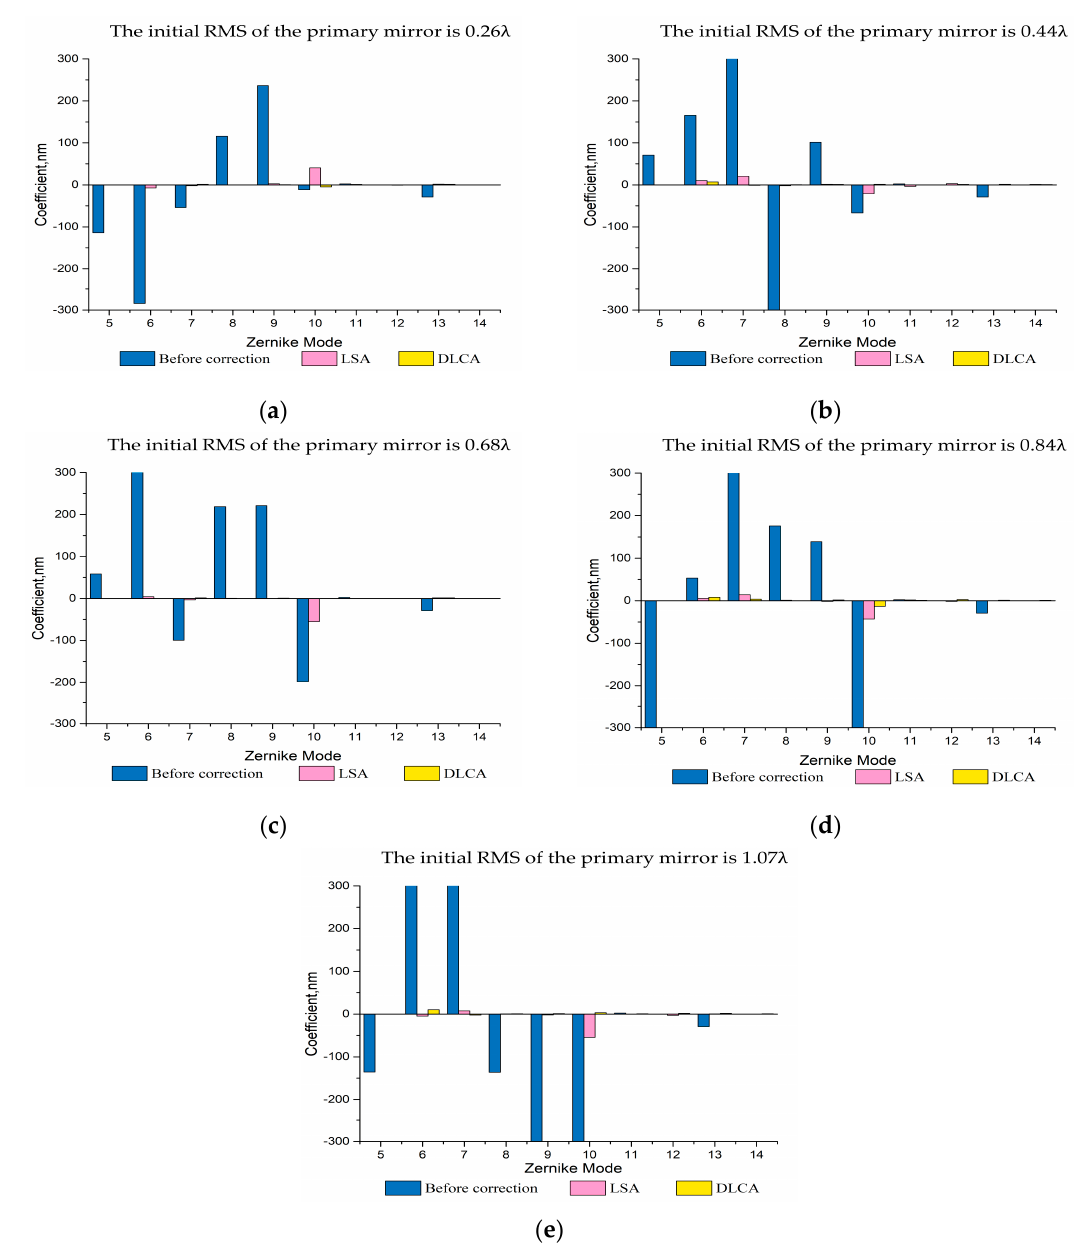
Figure 8. The correction results of LSA and DLCA in Zernike mode. ( a ) The initial RMS of the mirror is 0.26 λ ; ( b ) The initial RMS of the mirror is 0.44 λ ; ( c ) The initial RMS of the mirror is 0.68 λ ; ( d ) The initial RMS of the mirror is 0.84 λ ; ( e ) The initial RMS of the mirror is 1.07 λ .